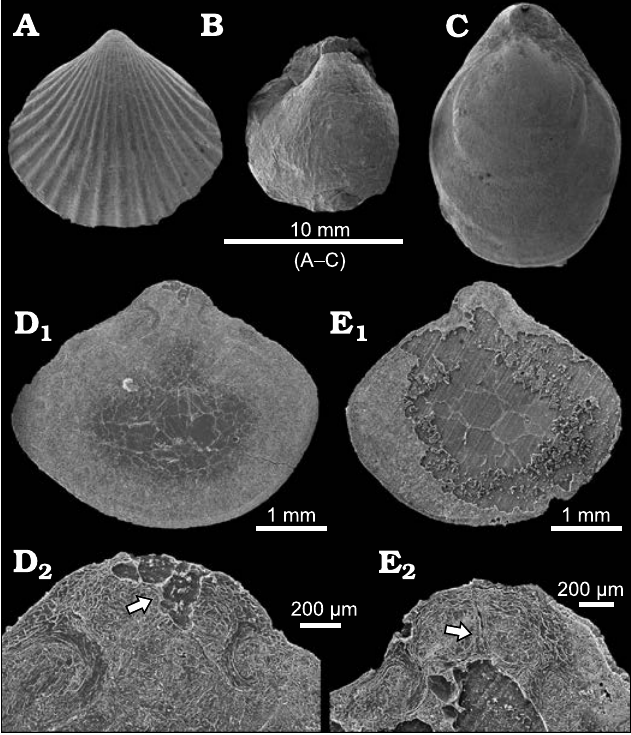
Fig. 15. SEM images of brachiopod specimens from the Brigantian (upper- most Visean) of Ricklow Quarry, near Monyash, Derbyshire, UK (localities RCC-, RCK-; Fig. 3). A . Pugnacid Pleuropugnoides pleurodon (Phillips, 1836), MPUM12013 (RCK15-4) in ventral view. B . Ambocoelid Crurithyris urei (Fleming, 1828), MPUM12030 (RCC42-25b) in ventral view. C . Gil- lediidid ? Balanoconcha sp., MPUM12094 (RCC10-15a) in dorsal view. D , E . Cranaenidid Harttella oakleyi Brunton, 1982. D . MPUM12088 (RCC65G-13), serial section 1.0 mm from the umbo. E . MPUM12088 (RCC48-31), serial section 1.6 mm from the umbo. Detail showing absence of dental plates (D 1 , E 1 ), focus showing Y-shaped septalium (D 2 , E 2